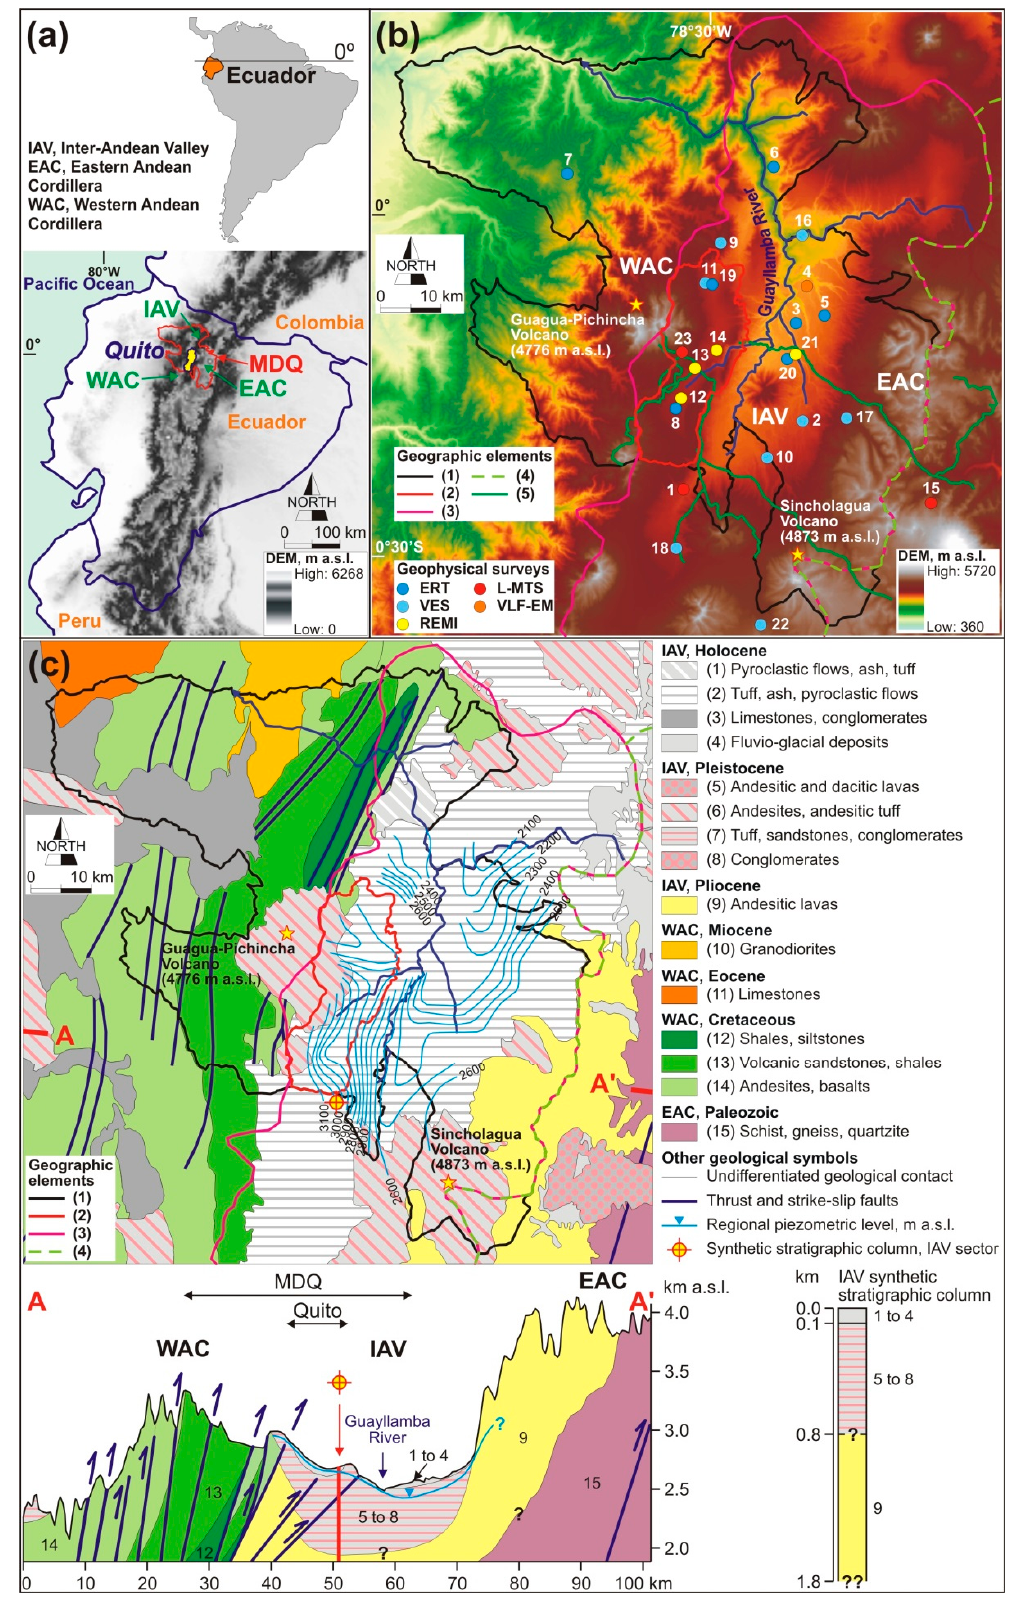
Figure 1. ( a ) Location of the study area. ( b ) The MDQ displayed using the 30 m-resolution Digital Elevation Model from Shuttle Radar Topography Mission (http://srtm.csi.cgiar.org/srtmdata/ (accessed on 11 February 2021), showing the loca- tion and typology of the compiled 23 geophysical prospecting surveys and additional geographical features cited in the text: (1) MDQ, (2) Quito city, (3) Quito-Machachi Hydrogeological Unit [24–26], (4) Cayambe-Rumiñahui Hydrogeolog-